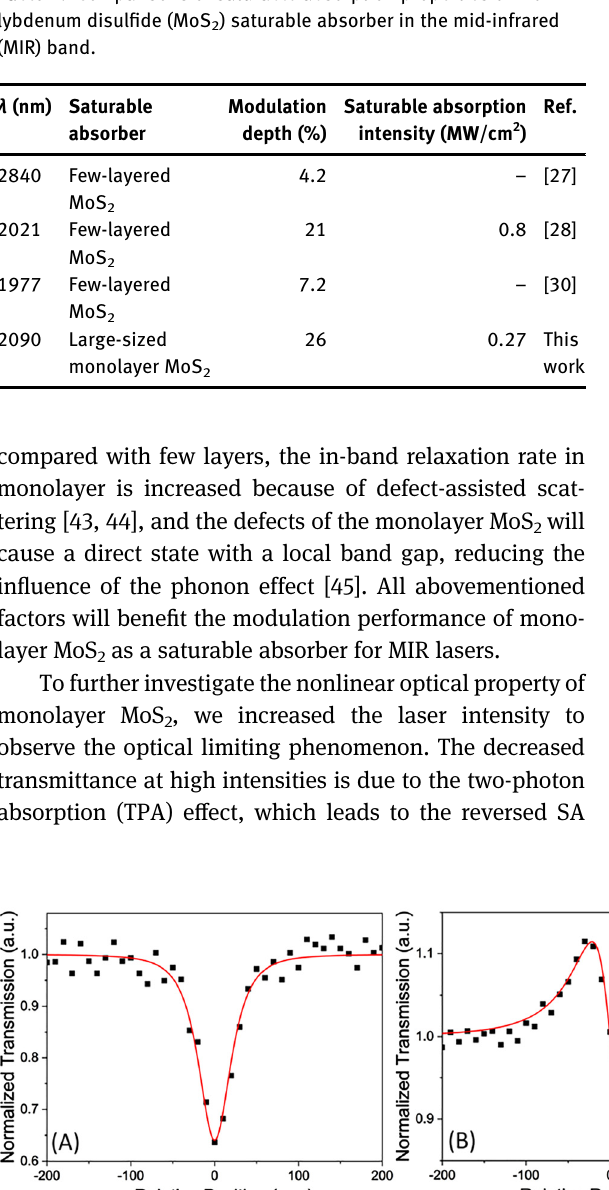
Figure 4: (A) Reversed saturable absorption (RSA) phenomenon at the light peak intensity of 2.35 MW/cm 2 (B) The results of closed-aperture (CA) Z-scan measure- ments. Lines: fi tting curves; dots: normalized transmission